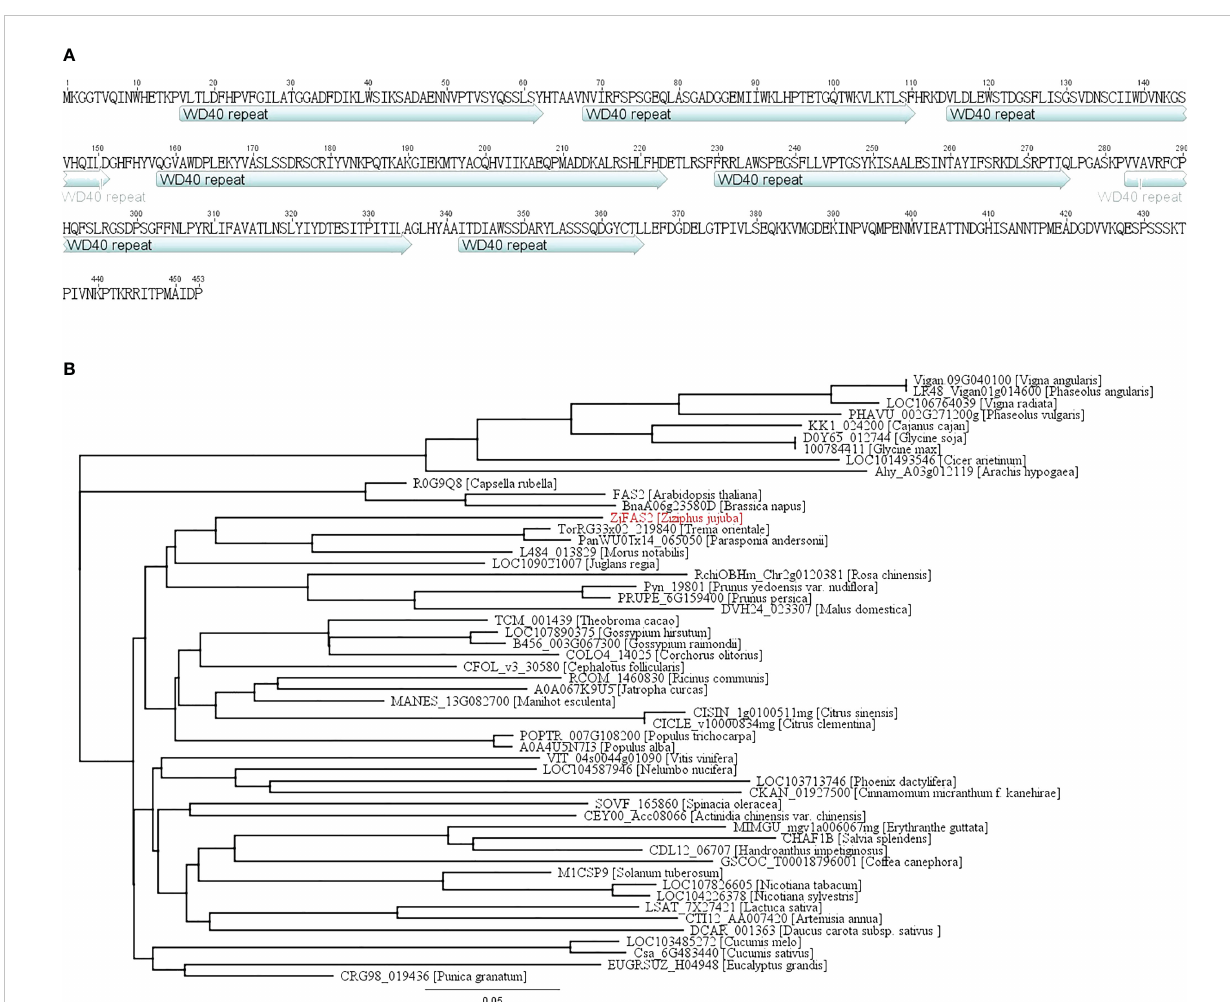
FIGURE 4 Protein sequence and phylogenetic analysis of ZjFAS2. (A) ZjFAS2 protein sequence. (B) Phylogenetic tree of the plant FAS2 protein. The lengths of the branches refer to the amino acid variation